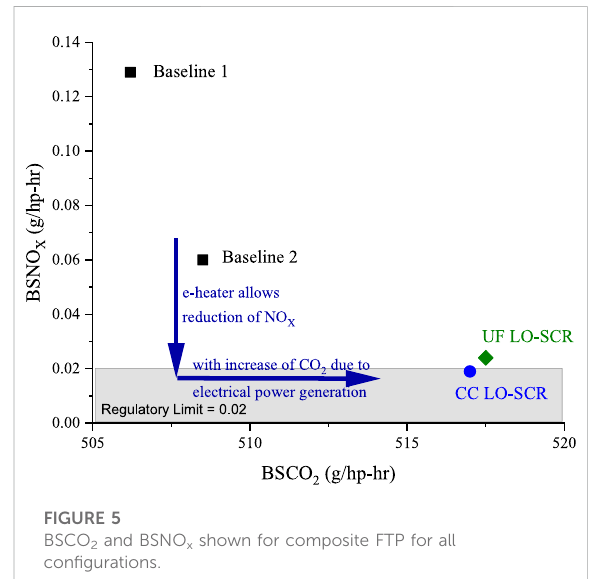
FIGURE 5 BSCO 2 and BSNO x shown for composite FTP for all con fi